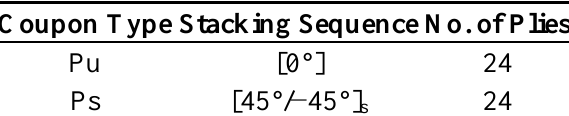
Table 1. Specimen characteristics.